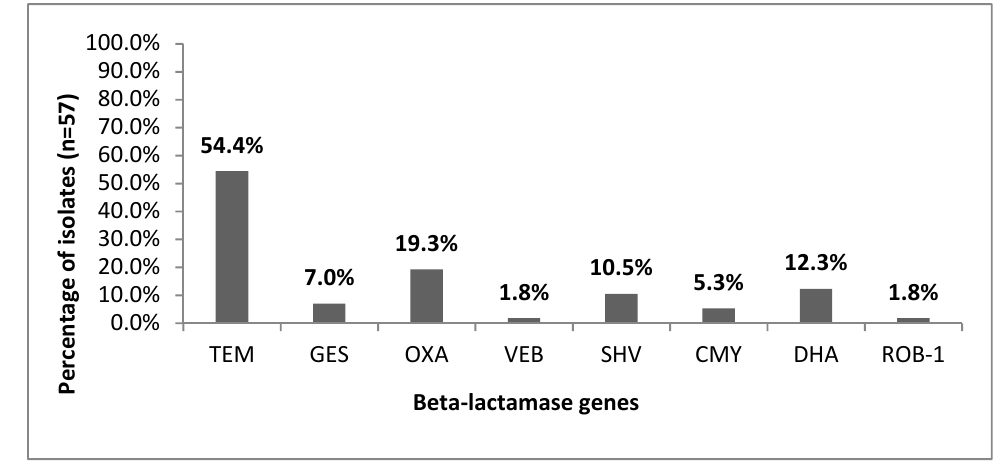
Figure 3. Presence of bla genes among Haemophilus parainfluenzae isolates ( n = 57).